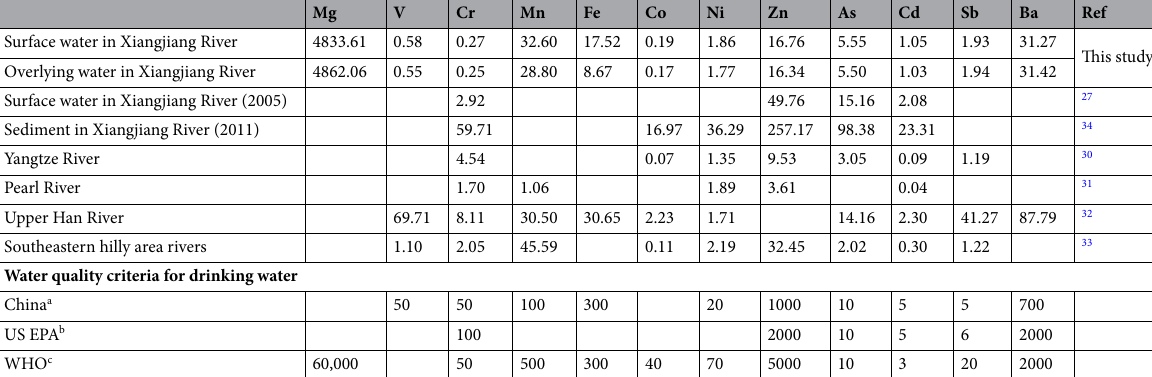
Table 1. Concentration of metals in the Xiangjiang River and other rivers in southern China, and permissible limits of metals in drinking water (μg/L for metal in water, μg/g for metal in sediment). a Chinese